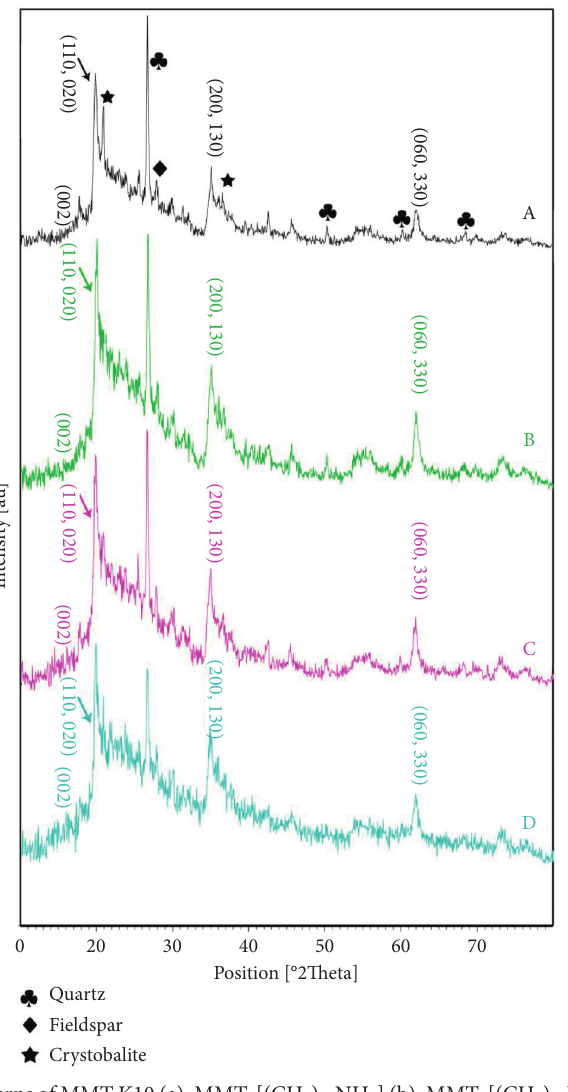
2 ) 3 -NH 2 ] (b), MMT-[(CH 2 ) 3 -NH